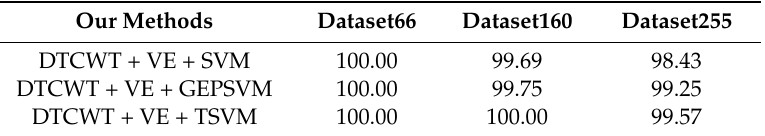
Table 3. Accuracy Comparison based on 10 runs of k-fold SCV (Unit: %).